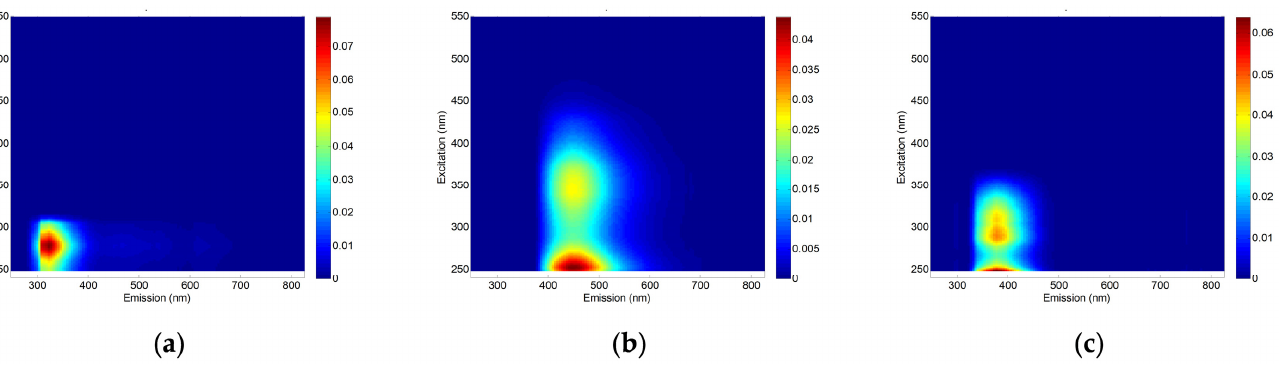
Figure 10. Contour plots of three components identified by the PARAFAC model: ( a ) C1; ( b ) C2; and ( c )